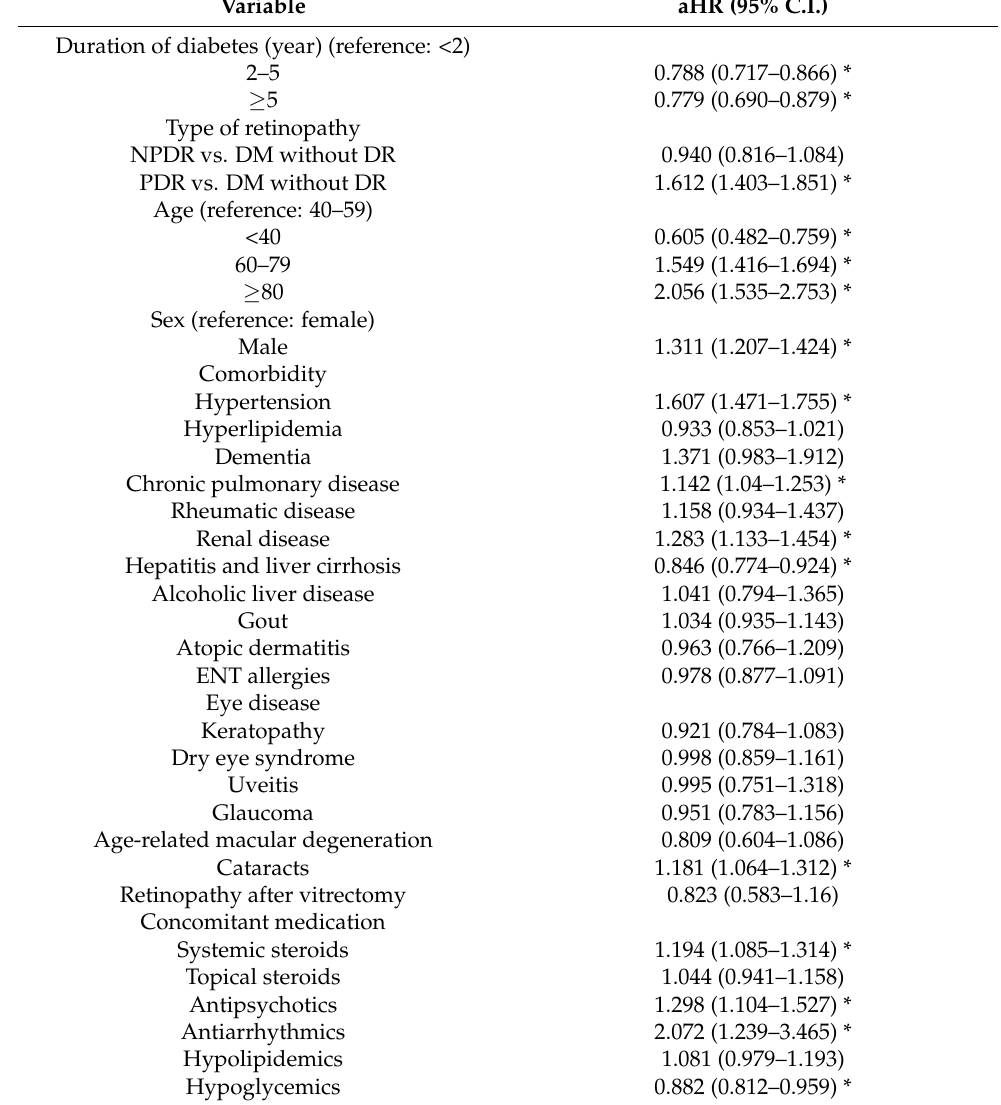
Table 5. Adjusted hazard ratios of CVD among the diabetic population. Variable aHR (95%